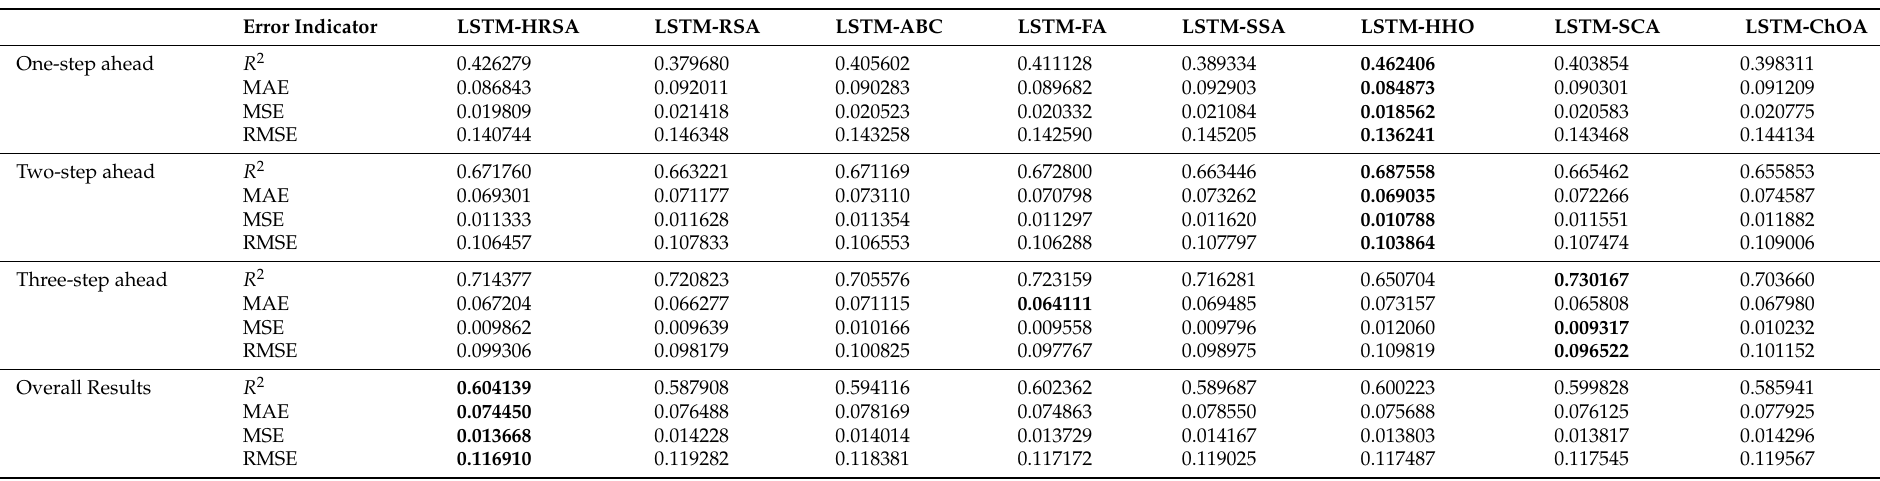
Table 2. Normalized metrics for one-step, two-step, three-step ahead, and overall predictions for LSTM experiments. The best result in each column is written in bold.